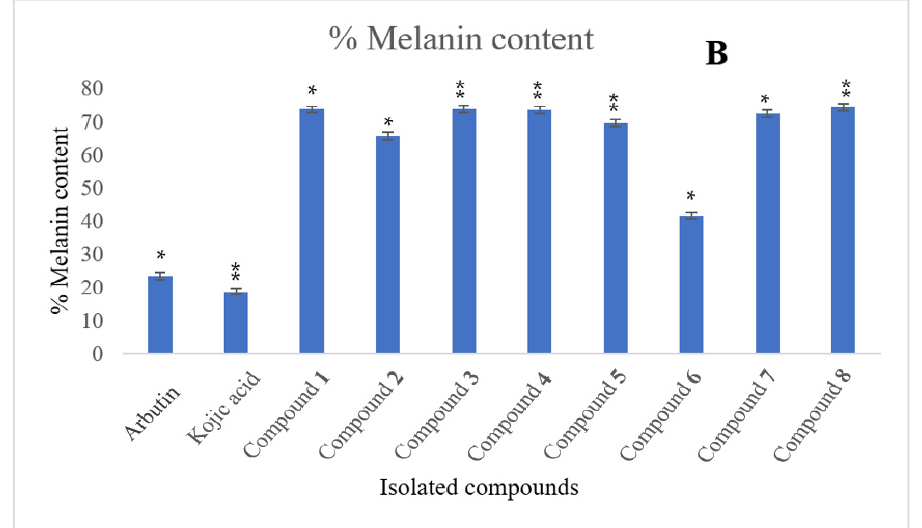
Figure 6. Intracellular antityrosinase activity ( A ) and melanin content ( B ). Data were expressed as mean ± SD from three independent experiments. * p < 0.05, and ** p < 0.01 indicated a significant difference from the positive control group. Positive controls were arbutin and kojic acid.